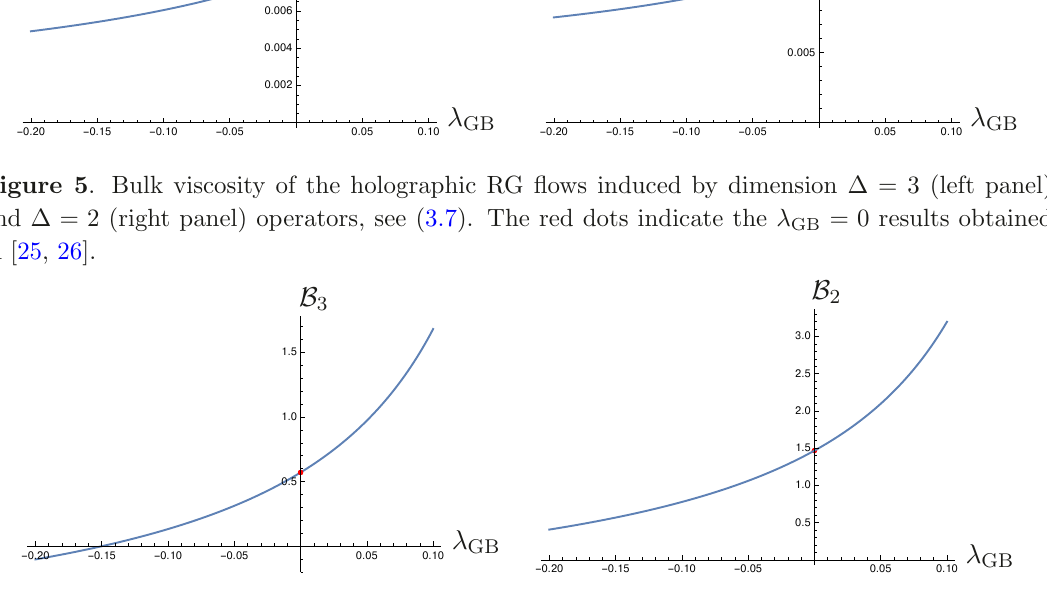
Figure 6 . Holographic bulk viscosity bound for RG flows induced by dimension ∆ = 3 (left panel) and ∆ = 2 (right panel) operators. The bound is violated whenever the bound at λ GB = 0, see